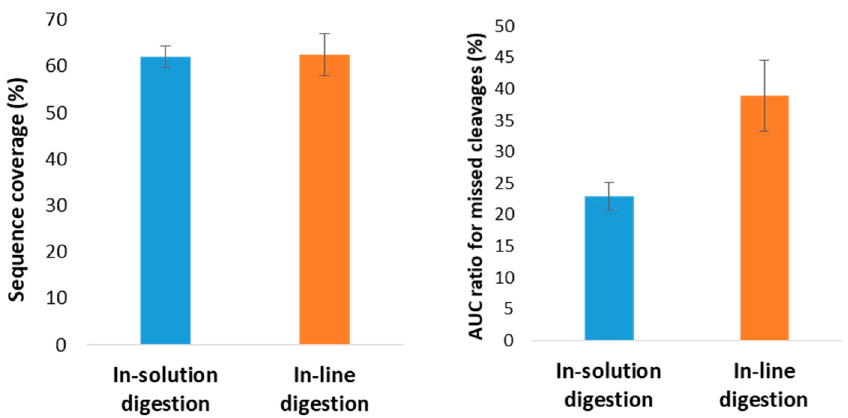
Figure 6. Comparison between in-solution and in-line digestion of human serum albumin in terms of sequence coverage% ( A ) and the ratio of missed cleavage peptides ( B ). The values shown are the averages of 10 consecutive measurements, using the parameters described in Figure 4.